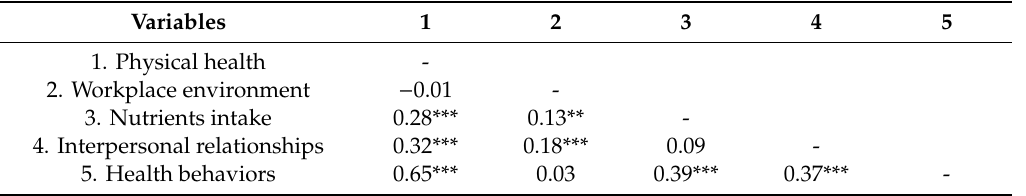
Table 2. Correlations for the study